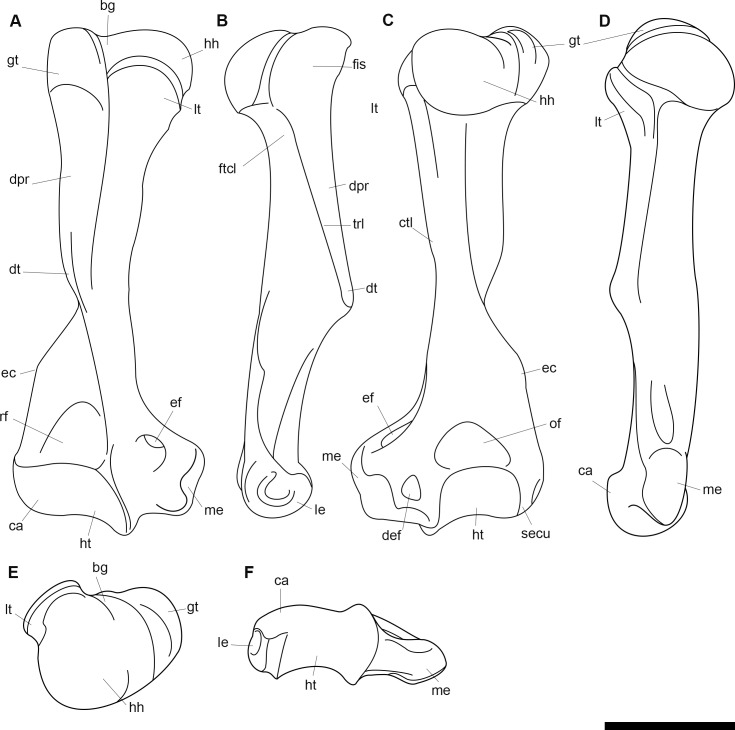
Annotated line drawing of the right humerus of Periptychus carinidens.(A) anterior view; (B) lateral view; (C) posterior view; (D) medial view; (E) proximal view; (F) distal view. Abbreviations: bg, bicipital groove; ca, capitulum; ctl, crest for insertion of the teres major and latissimus dorsi; def, dorsoepitrochelar fossa; dt, deltoid tuberosity; dpr, deltopectoral region; ec, epicondylar crest; ef, entepicondylar foramen; ftcl, fossa for the caput longum of the triceps brachii; fis, fossa for insertion of the infraspinatus; gt, greater tubercle; hh, humeral head; ht, humeral trochlea; le, lateral epicondyle; lt, lesser tubercle; me medial epicondyle; of, olecranon fossa; rf, radial fossa; secu, sulcus for the extensor carpi ulnaris; trl, tricipital line. Scale bar: 30mm.